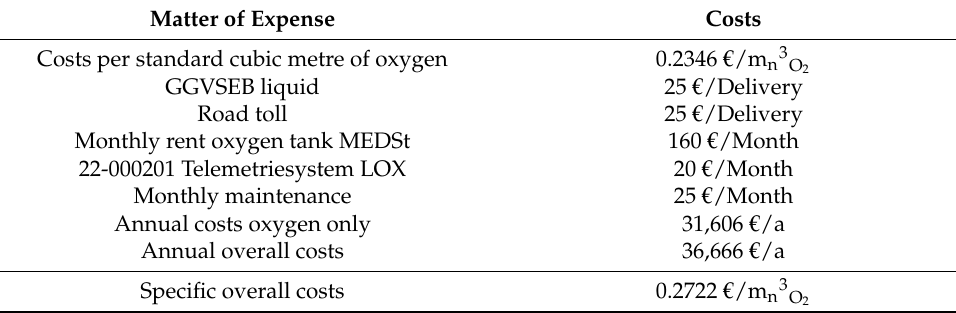
Table 6. Running costs for liquid oxygen.